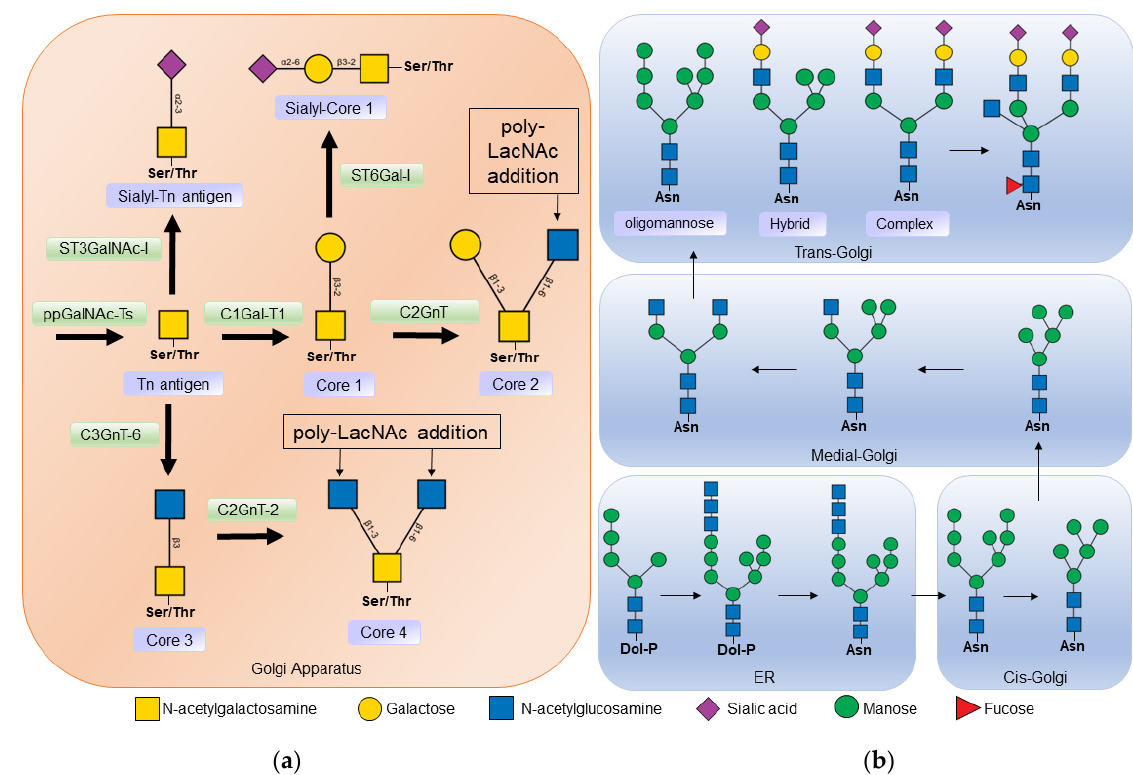
Figure 2. ( a ) Biosynthesis of O -glycans. O -glycosylation occurs in the Golgi apparatus, where N -acetyl-galactosamine is linked to a serine or threonine residue by the action of polypeptide N -acetylgalactosaminyltransferase (ppGalNAc-Ts) forming the Tn antigen. Core 1 β 1-3 galactosyltransferase 1 (C1Gal-T1) then binds to a galactose to form core 1. Core 1 can be a substrate for some sialyltransferase or core 2 β 1-6 N -acetylglucosaminyltransferase (C2GnT) to thus form core 2. Core 3 is formed from insufficient Tn by the action of core 3 β 1-3 N -acetylglucosaminyltransferase 6 (C3GnT-6); in turn, core 3 is a substrate to form core 4 by the addition of another N -acetyl-glucosamine by Core 2/4 β 1-6 N -acetylglucosaminyltransferase 2 (C2GnT-2). ( b ) Biosynthesis of N -glycans. Synthesis begins in the endoplasmic reticulum (ER), where a dolicholphosphate oligosaccharide is transferred to an asparagine residue by oligosaccharyltransferase (OST). Next, α -glucosidases I and II, and α -mannosidase I cleave the sugars from the oligosaccharide. The protein is then transported to the Golgi apparatus, where other mannosidase result from the processing of the N -glycan. In the middle part of the Golgi apparatus, N -acetylglucosaminyltransferase 1 (MGAT1) adds N -acetyl-glucosamine to begin the synthesis of hybrid and complex N -glycans. In the Trans Golgi part, fucoses, sialic acids, and poly-lactosamine chains, α 2-6 sialyltransferase (ST3GalNAc), α 2-6 sialyltransferase (ST6Gal), poly- N -acetyllactosamine (Poly-LacNAc) are added.